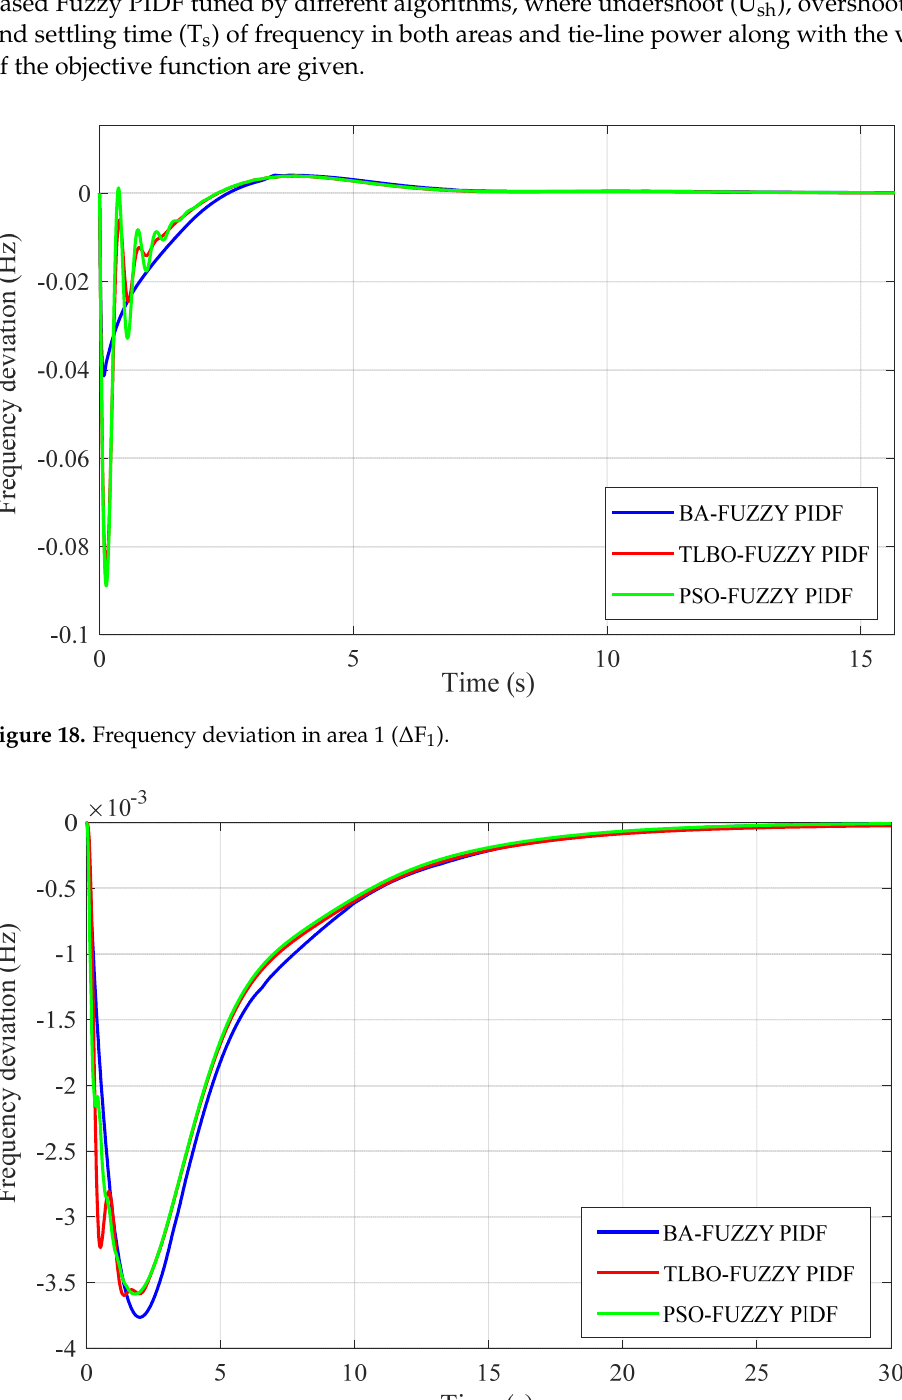
Figure 20. Tie-line power deviation ( ∆ P tie ). Table 20. Frequency response performances with different controllers. Controller